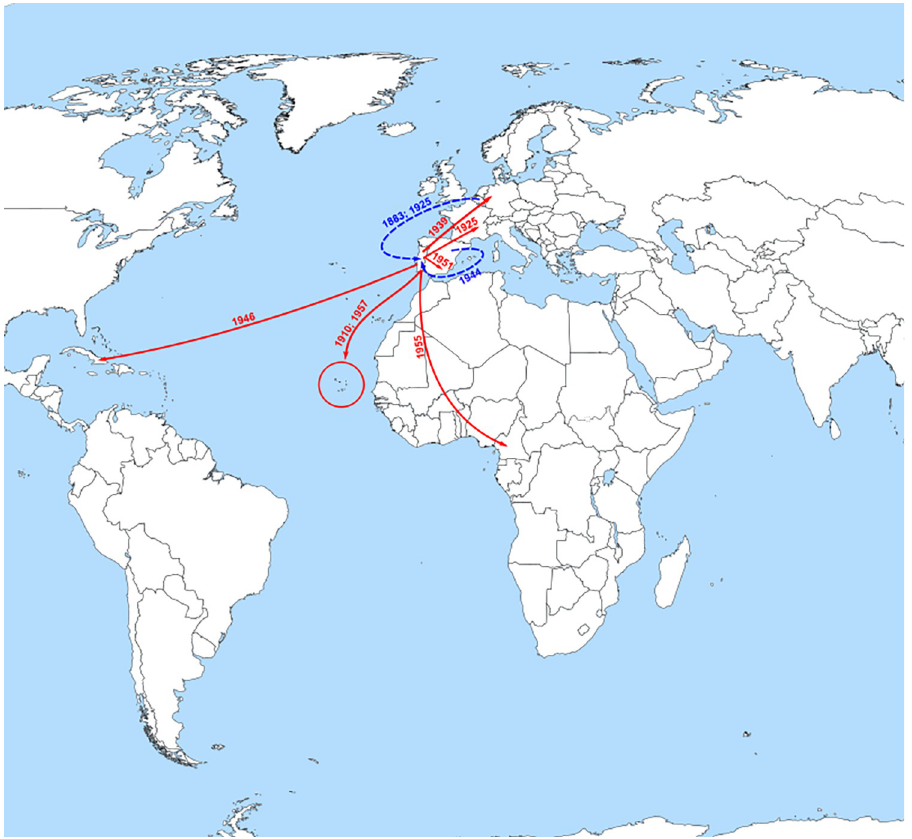
Fig 3. Probable major dispersal pathways of HBV/A2 as estimated by phylogeographic analysis. The dashed blue arrows represent probable routes of introduction of the HBV/A2 in Portugal. The solid red arrows represent the probable dispersion paths of HBV/A2 from Portugal towards other countries. This figure is a derivative of “World map blank with blue sea.svg” licensed under the Creative Commons Attribution-Share Alike 4.0 International, modified with the addition of dates, dashed blue and solid red